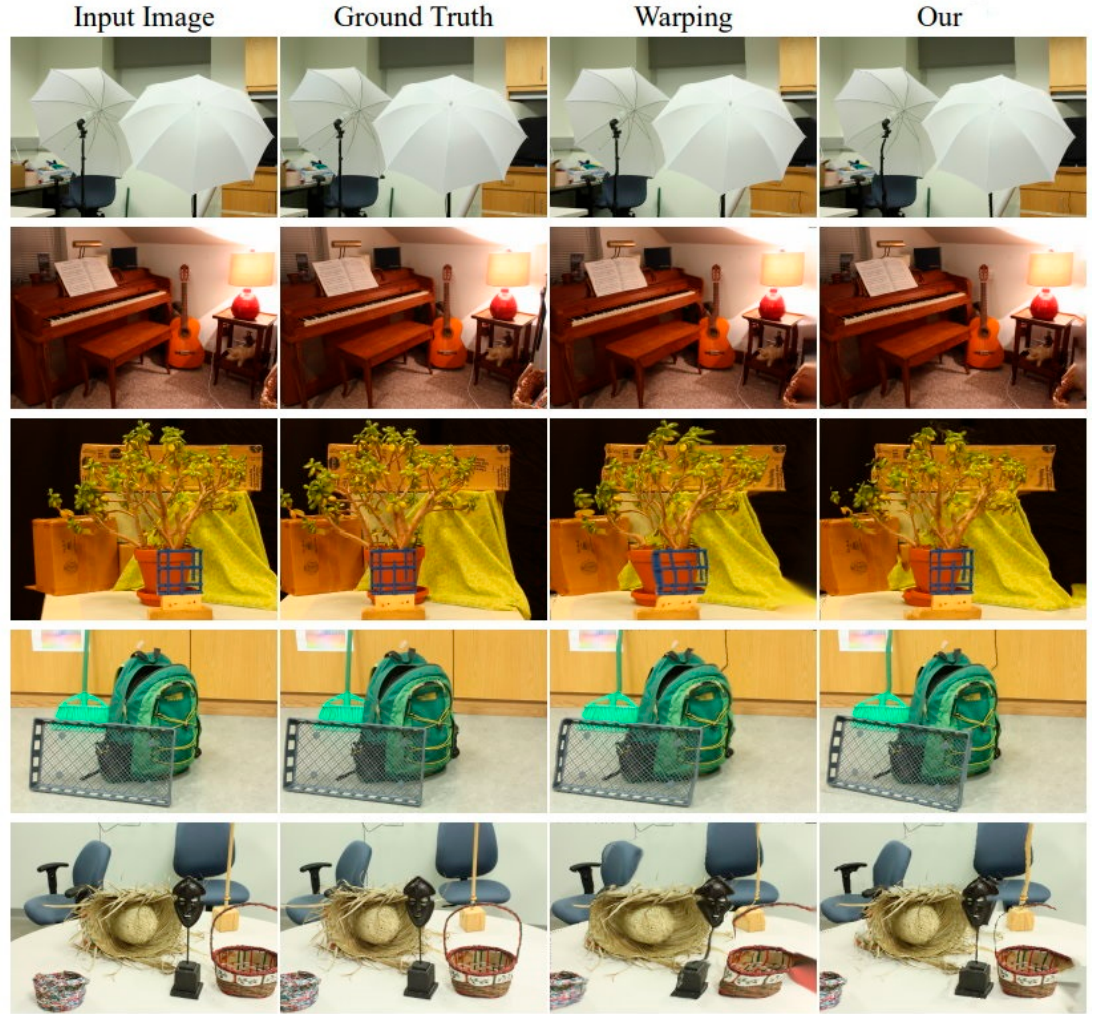
Figure 8. Perfect-pair images using warping and our model. From top to bottom, these are umbrella, piano, jadeplant, backpack and mask.